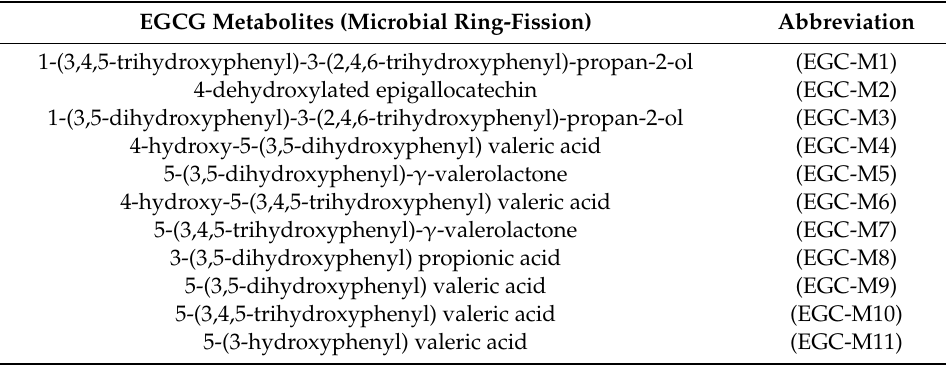
Table 1. Microbial ring-fission metabolites of EGCG in